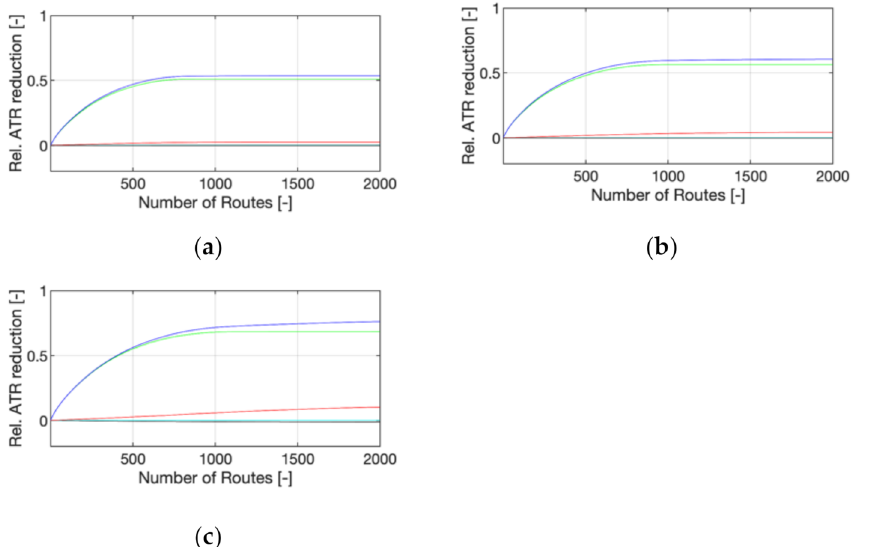
Figure 8. Cumulative average temperature response (ATR) reduction as a function of the number of changed routes for 1% ( a ), 2% ( b ), and 12.8% ( c ) increase in fuel burn for the top 2000 routes. Individual contributions to the total ATR reduction (blue) are shown for CO 2 (black), H 2 O (cyan), NO x (red), and contrails